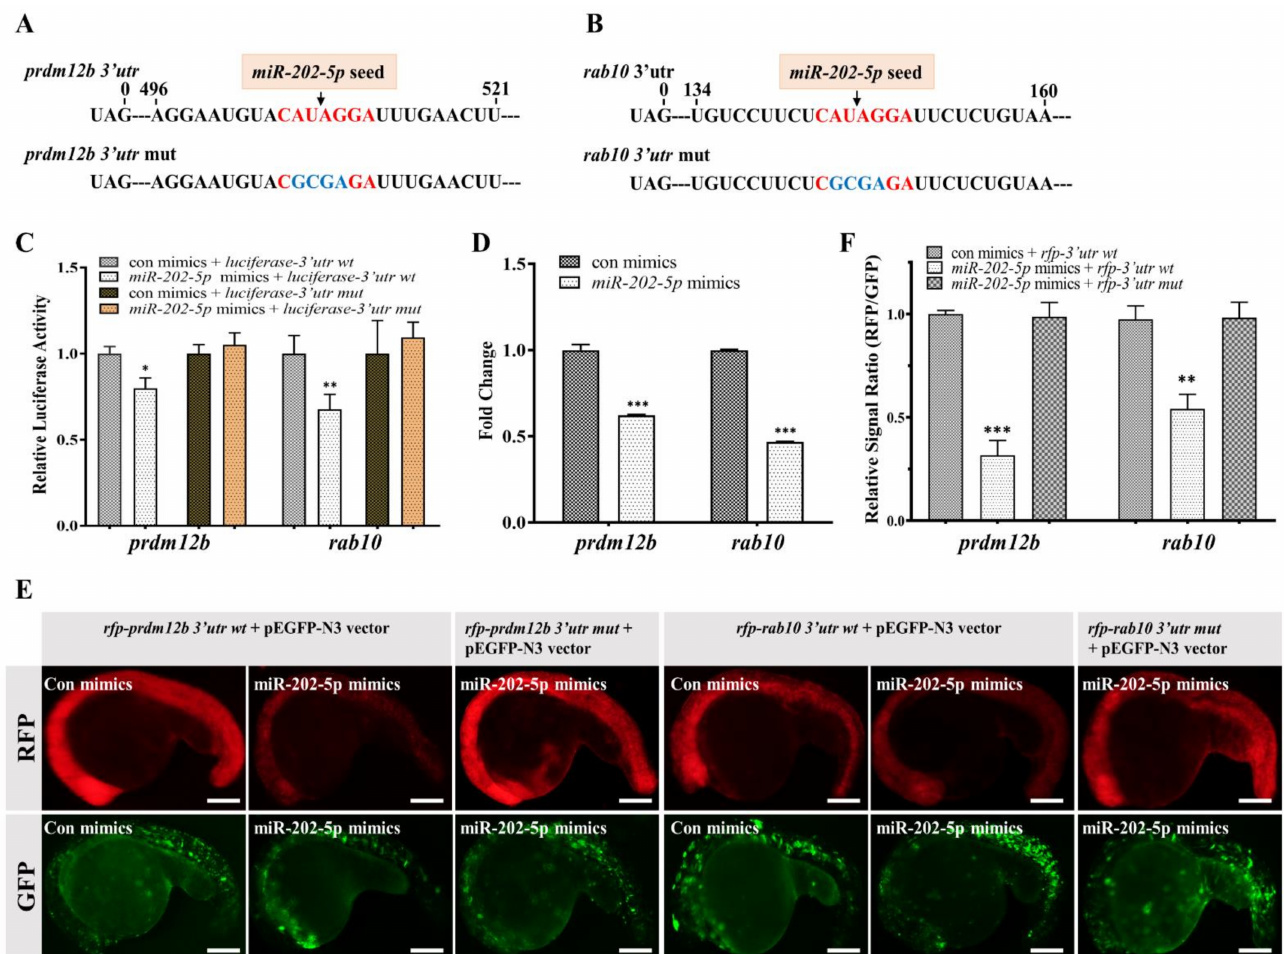
Figure 3. miR-202-5p directly regulates prdm12b and rab10 . ( A , B ) The sequence information of the 3 (cid:48) utr of prdm12b and rab10 . The canonical miR-202-5p binding sites and its mutant were shown in red and blue, respectively. ( C ) Relative luciferase activity in HEK293T cells transfected with psiCHECK2 − 3 (cid:48) utr wt ( prdm12b or rab10 ) or psiCHECK2- 3 (cid:48) utr mut ( prdm12b or rab10 ) in the presence of control mimics (con mimics) or miR-202-5p mimics. ( D ) qRT-PCR analysis of prdm12b and rab10 mRNA in 24hpf embryos injected with control or miR-202-5p mimics. ( E ) The representative images of embryos co-injected with mRNAs of rfp-prdm12b 3 (cid:48) utr wt , rfp-prdm12b 3 (cid:48) utr mut , rfp-rab10 3 (cid:48) utr wt or rfp-rab10 3 (cid:48) utr mut in the presence of control or miR-202-5p mimics. All embryos were co-injected with pEGFP-N3 vector as a control. ( F ) The relative signal ratio of RFP/GFP in the experiment presented in ( E ). ( C , D , F ) The results were representative of more than three independent experiments in triplicate. β -actin was used as an internal control to normalize gene expression levels with 2 − ∆∆ Ct method * p < 0.05; ** p < 0.01; *** p <